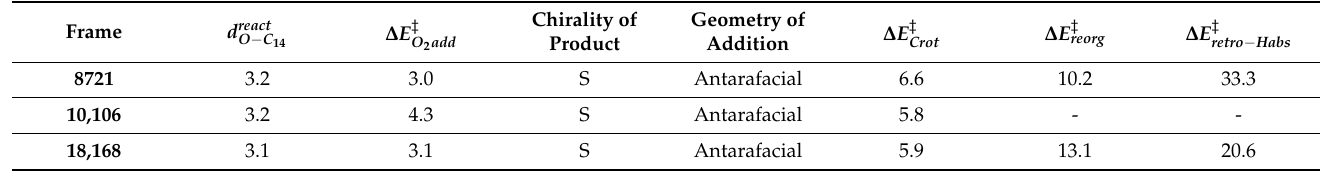
Table 2. Number of the MD frame used as initial coordinates for the QM/MM optimization in hALOX12; optimized O-C 14 distances (in Å) at the reactants and potential energy barriers for the addition reaction as well as the chirality of the peroxyl product and the geometry of the addition approach; potential energy barriers for the rotation of the peroxyl radical’s carbon chain and for the retro-hydrogen abstraction (reorganization of the peroxyl radical and retro-hydrogen abstraction itself). All energies are in